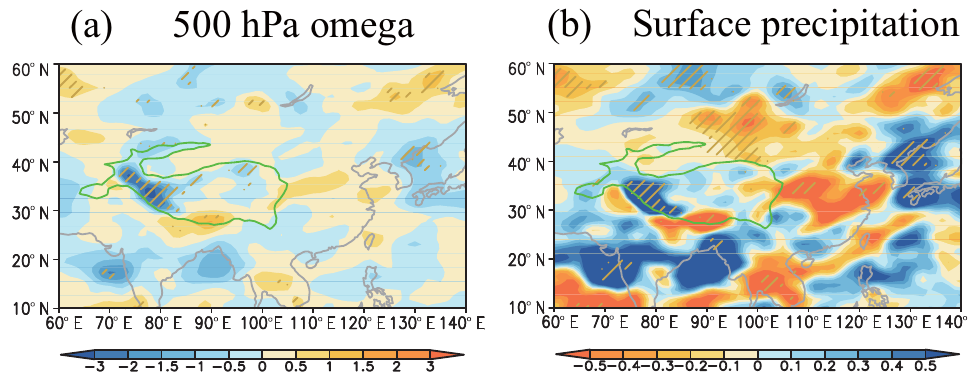
Figure 11. Spatial distribution of the changes in (a) the 500hPa omega (0 . 01 × Pas − 1 ) and (b) the surface precipitation (mmday − 1 ) in June–July–August (JJA) induced by the dust-in-snow radiative forcing. The slanted lines represent the grid points where the changes pass the two-tailed t test at the 5% significance level. The green outlined area indicates the plateau above